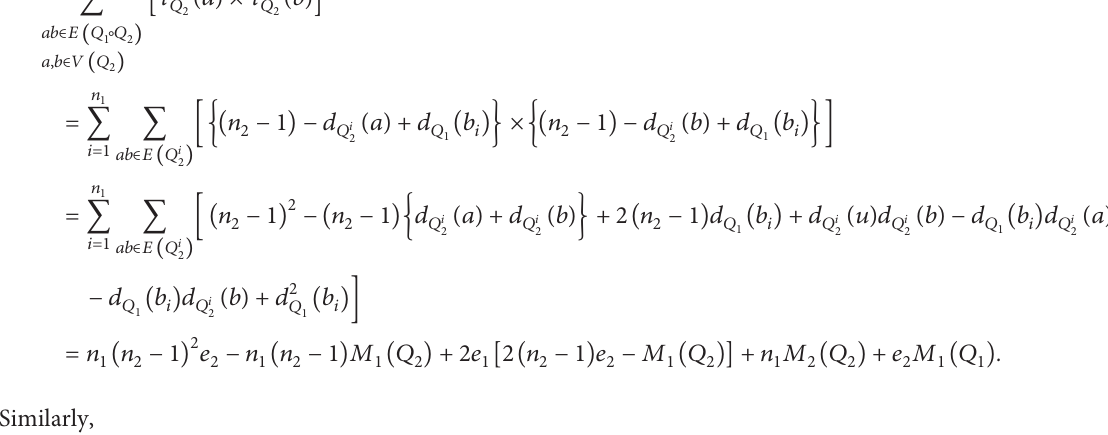
� P , and (c) LexicographicProduct ( C 2 2